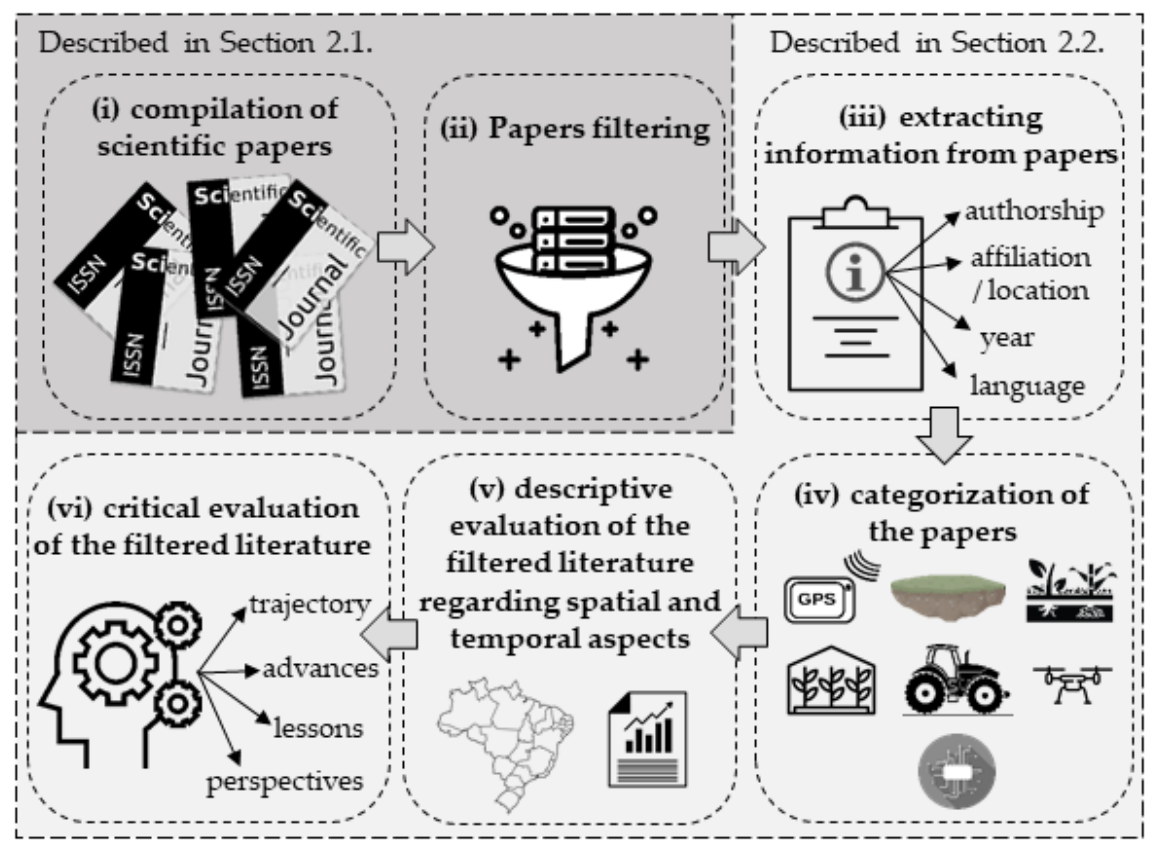
Figure 2. Framework of the methodology applied for surveying and analyzing the trajectory of the last 25 years of precision agriculture in the Brazilian scientific bibliography.